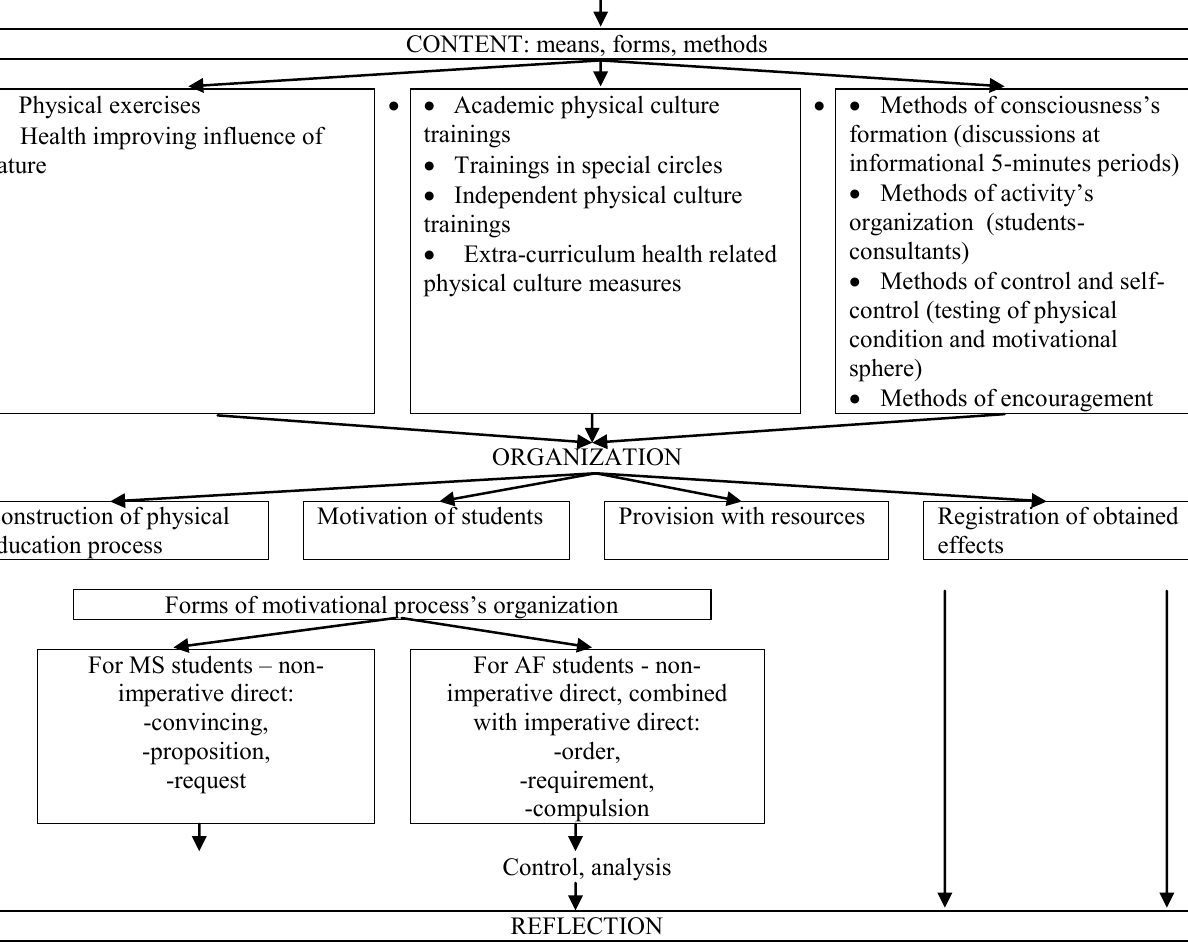
Fig.2. Model of technology “Regulation of students’ motion activity, depending on motivation for achievement of success or avoiding of